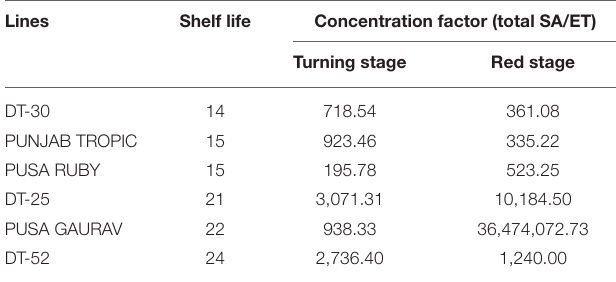
TABLE 2 | Concentration factors of the tomato